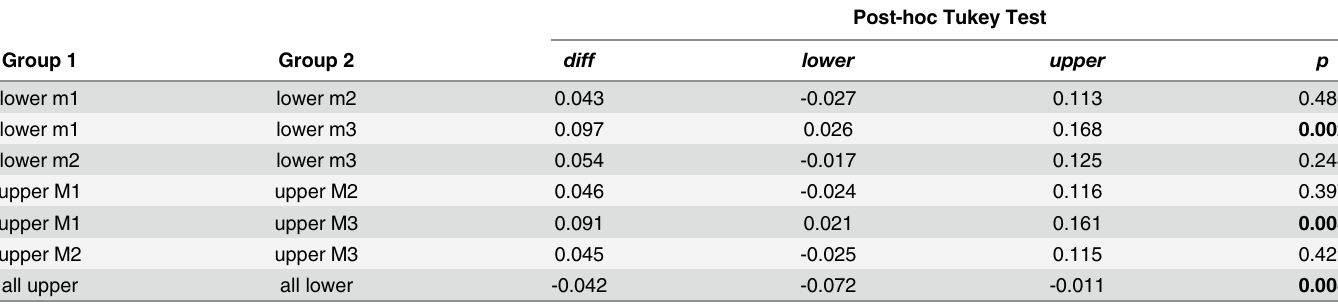
Table 4. Results of Post-hoc Tukey test for multiple comparisons of means with 95% family-wise confidence level. Values in bold indicate a signifi- cant difference ( p (cid:1) 0.05) for relative enamel content between tooth positions. Statistics abbreviations: diff = difference between group means, lower = lower end point of the interval, upper = upper end point of the interval, p = significance